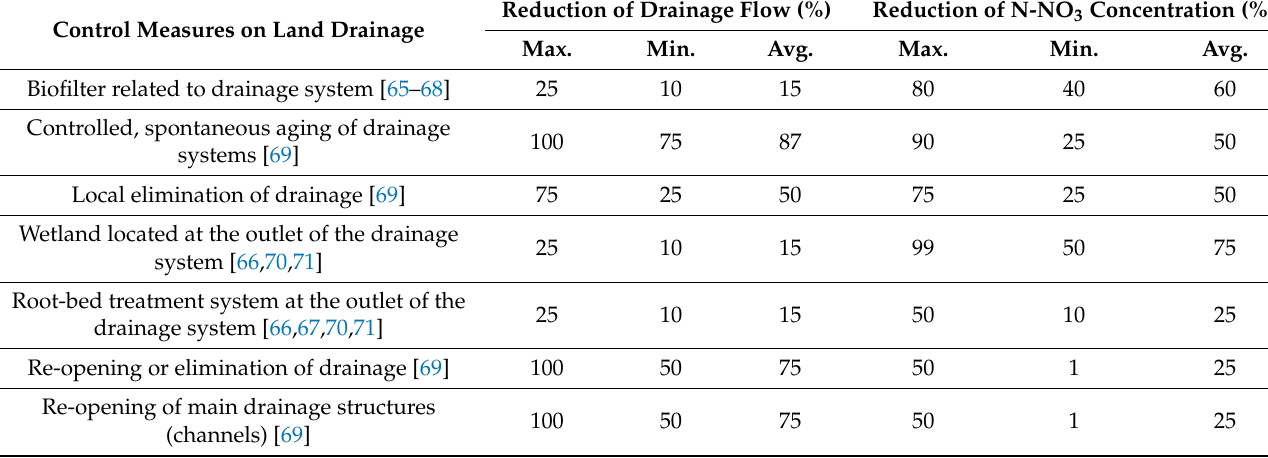
Table 4. Effectiveness of measures on land drainage as used in this